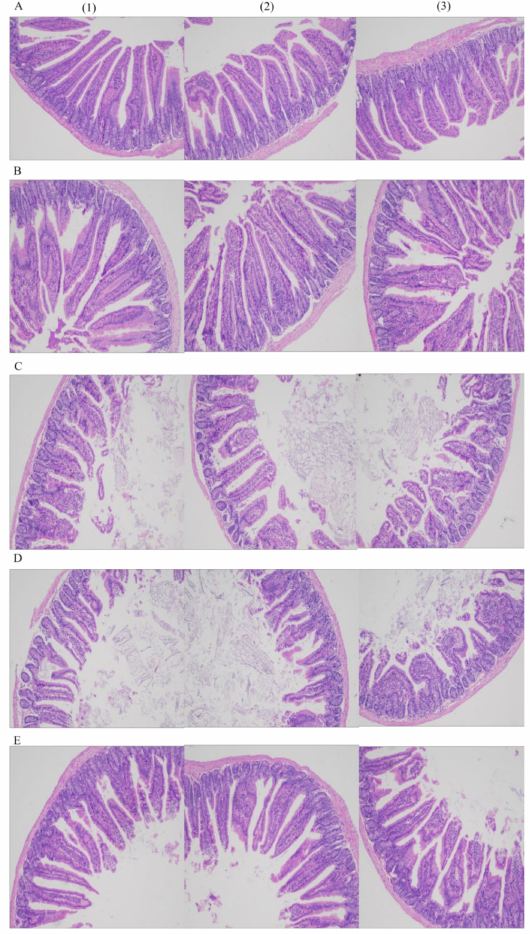
Figure 3. The morphology of terminal ileum (100 × ) in each group ( A – E refer to L-group, Y-group, LY-group, R-group and W-group, respectively, ( 1 )–( 3 ) refer to three 100 × field of view). Villus height and crypt depth in the five groups were measured (Table 2).